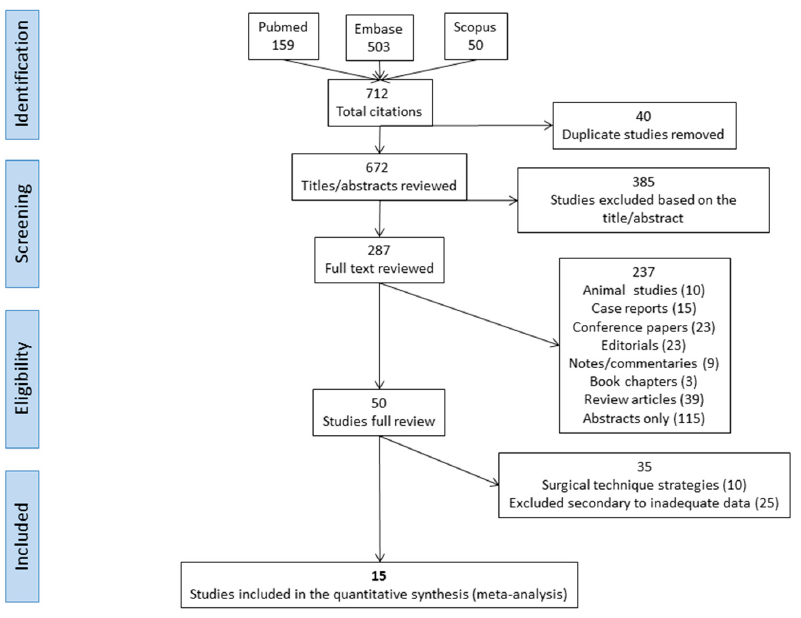
Figure 1. Flow diagram representing literature search and study selection process.